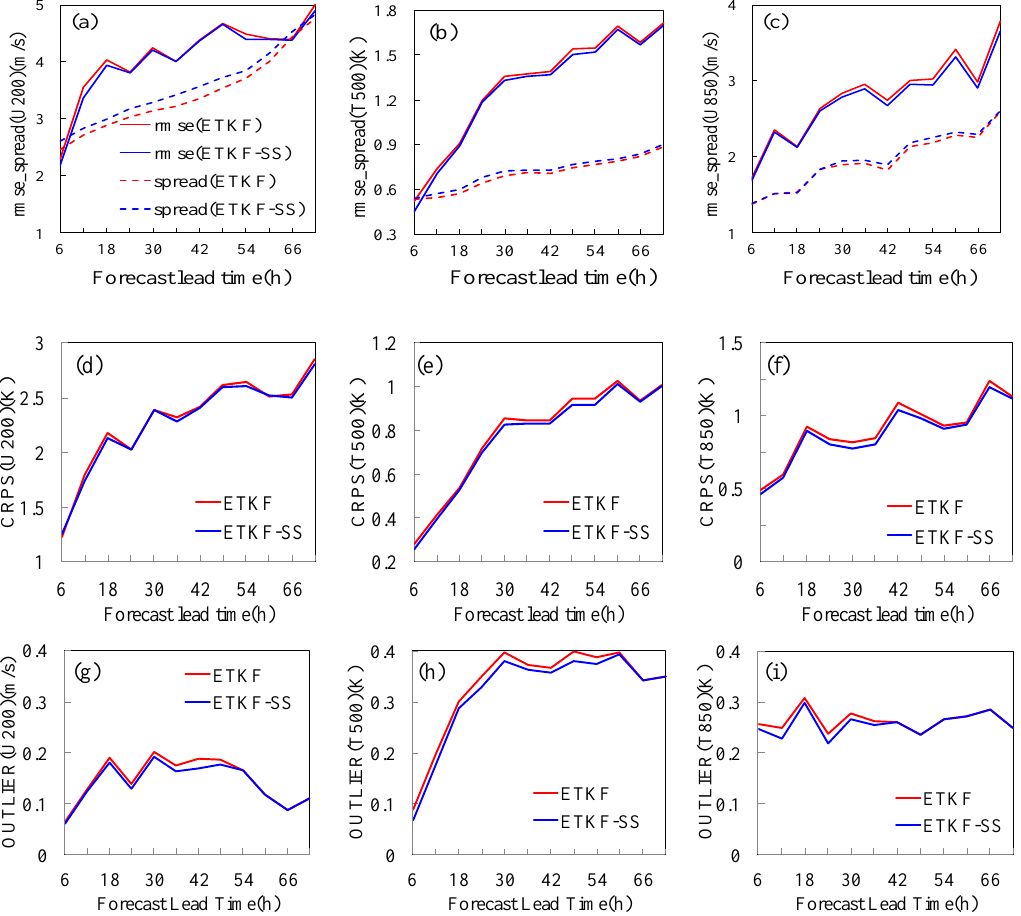
Figure 9. The verification of ensemble forecast of ETKF and ETKF-SS, ( a – c ), the time-series of rmse and spread of U200 hPa, T850 hPa, and U850 hPa, respectively; ( d – f ), the time-series of CRPS of U200 hPa, T850 hPa, and U850 hPa, respectively; ( g – i ), the time-series of outlier of U200 hPa, T850 hPa, and U850 hPa, respectively.